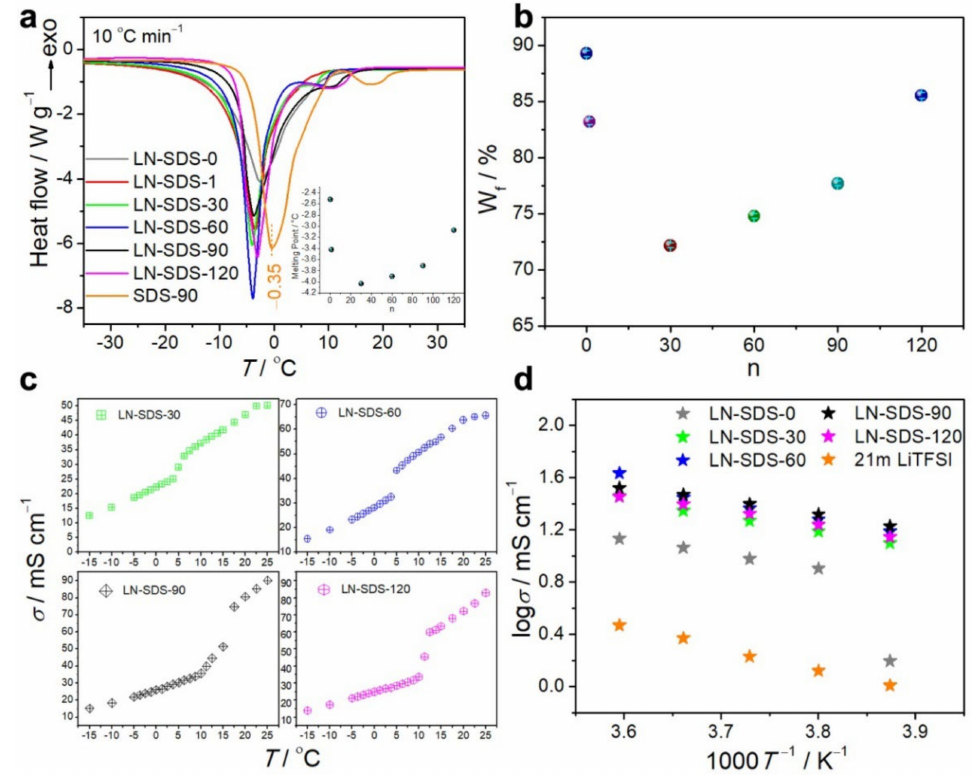
Figure 2. ( a ) DSC curves, inset is the melting point plot (RSD < 0.3%). ( b ) Plot of freezable water concentration vs. n (RSD < 0.3%). ( c ) Plots of ionic conductivity vs. temperature. ( d ) Plots of log σ vs. 1000/ T , and 21 m LiTFSI is provided for